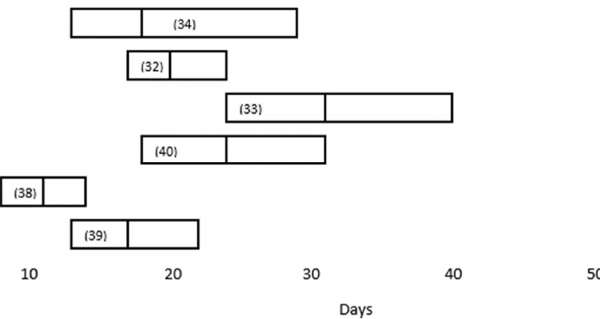
Figure 2. Duration of SARS-CoV-2 RT-PCR positivity in respiratory specimens reported in studies of adult COVID-19 patients cited in this review. Vertical lines represent the median duration, and the boxes represent the interquartile range. The study reference numbers are in parentheses. See text for additional details.